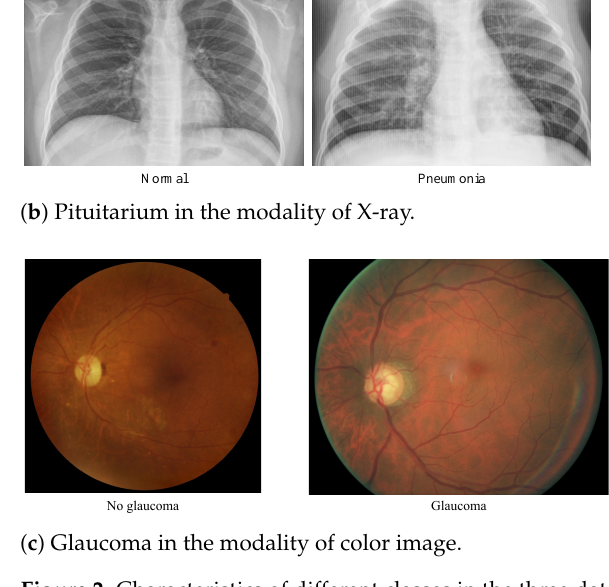
Figure 2. Characteristics of different classes in the three datasets. Table 1. Statistics of the used three medical imaging